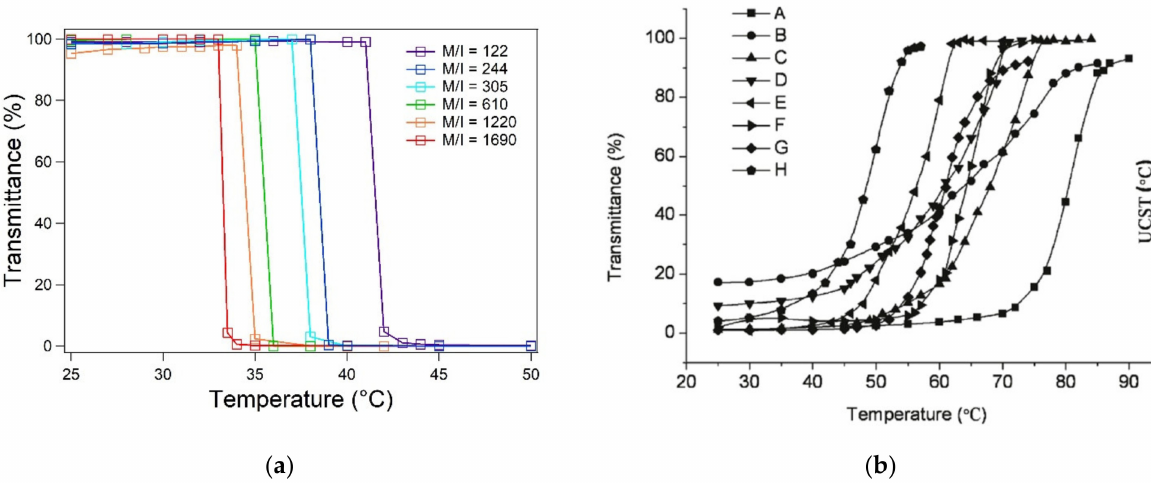
Figure 6. ( a ) Miscibility curves of PNVCL-COOH polymers (5.0 mg mL − 1 aqueous solutions) with different molec- ular weights [161]. ( b ) Influence of structural parameters on temperature dependence of transmittance changes for 4.0 mg mL − 1 aqueous solutions of PVA-PPDO copolymers. Reprinted with permission from [131]. Copyright 2011, American Chemical